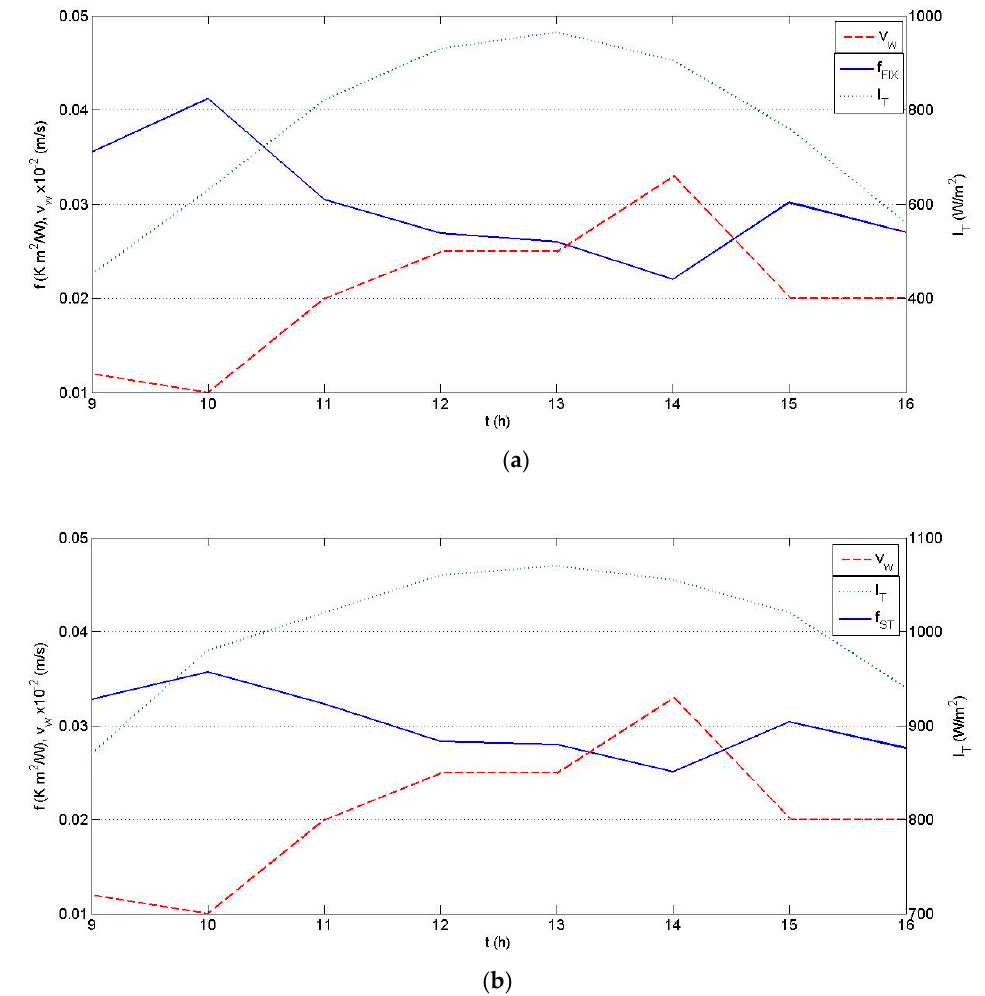
Figure 2. f versus t as determined for the mid-day of March with parameters v w and I T . The strong impact of v w on f is obvious. ( a ) Corresponds to the FIX PV system and ( b ) to the sun tracking (ST) one.